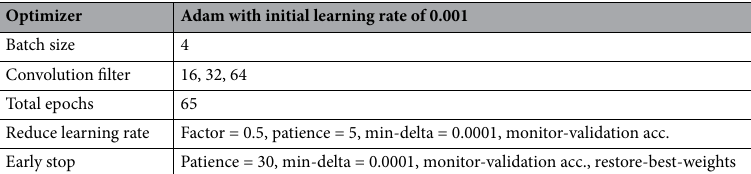
Table 3. Details of hyper